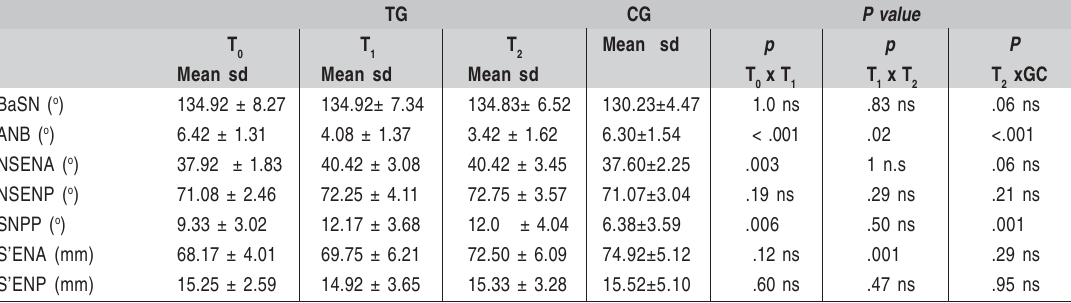
Time intervals: before treatment (T